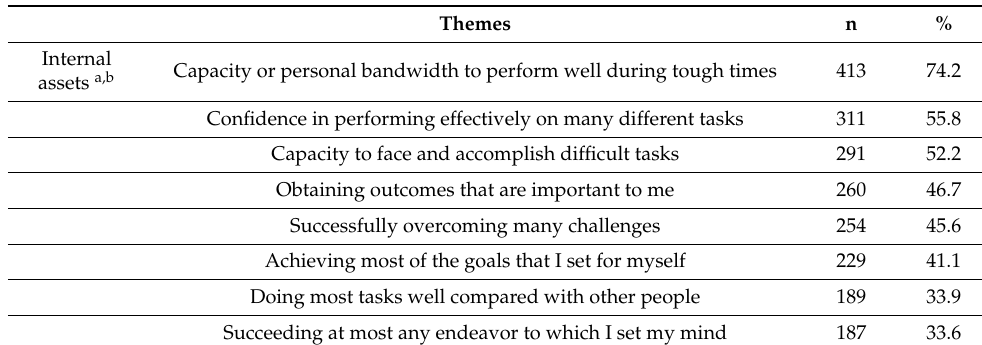
Table 8. Percentage of perceived internal and external resilience assets and resources for coping with stress in treating COVID-19 patients, Sept.–Dec.